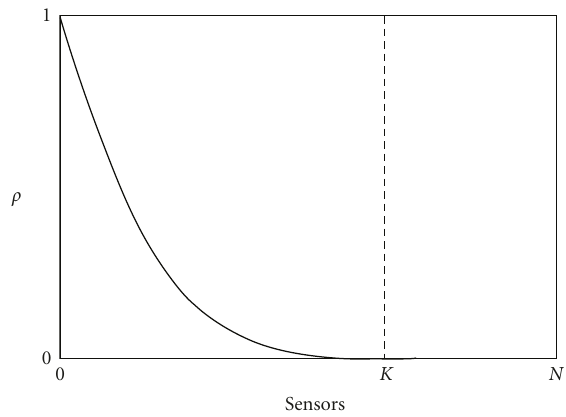
Figure 1: Noise correlation along a uniform linear array with N sensors, ρ is the noise spatial correlation coe ffi